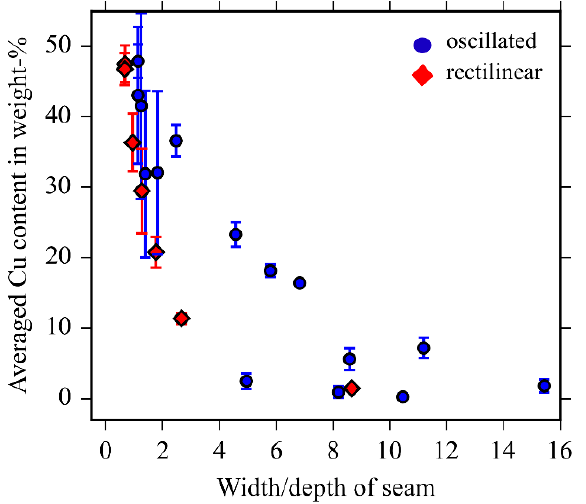
Figure 13. Dependence of the averaged Cu content in the weld seam on the ratio of seam width to depth for welds produced with spatial beam oscillation (blue) and rectilinear welds (red). The error bars indicate the standard deviation.